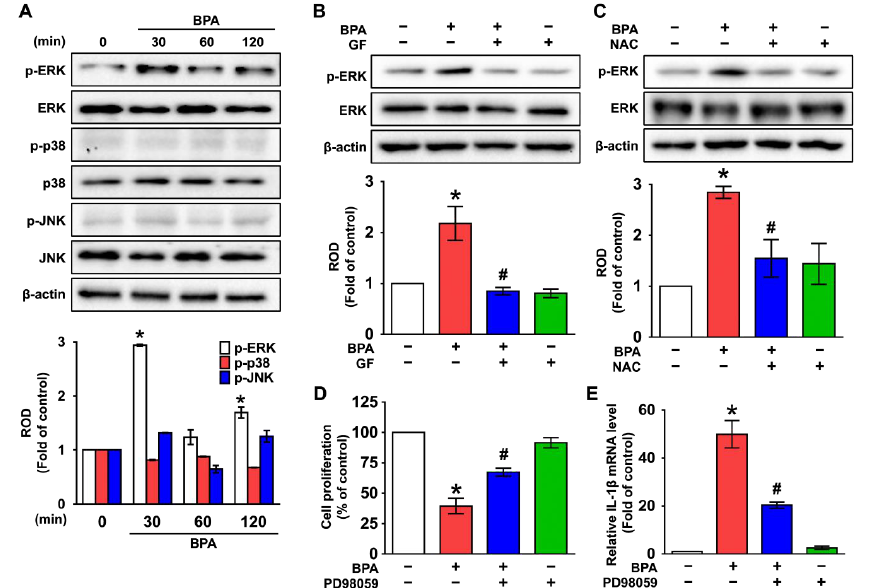
Figure 4. GF inhibits the phosphorylation of ERK in BPA-induced NHDFs. ( A ) Time-dependent response of phosphorylation of MAPKs in NHDFs treated with BPA is shown. n = 4. * p ≤ 0.05 vs. 0 min. ROD, relative optical density. ( B ) The inhibitory effect of GF on phosphorylation of ERK in BPA-treated NHDFs is shown. n = 4. * p ≤ 0.05 vs. Cont., # p ≤ 0.01 vs. BPA alone. ( C ) NHDFs were incubated with NAC for 30 min prior to BPA treatment for 30 min. n = 4. * p ≤ 0.05 vs. Cont. # p ≤ 0.01 vs. BPA alone. NHDFs were pretreated with ERK inhibi tor, PD98059 (1 μM) for 30 min prior to BPA exposure for 6 h. n = 4. The level of cell proliferation ( D ) and IL- 1β mRNA ( E ) is shown. * p ≤ 0.01 vs. control. # p ≤ 0.01 vs. BPA alone. n = 4. The green squares indicate the cells treated with GF, NAC, or PD98059 alone.